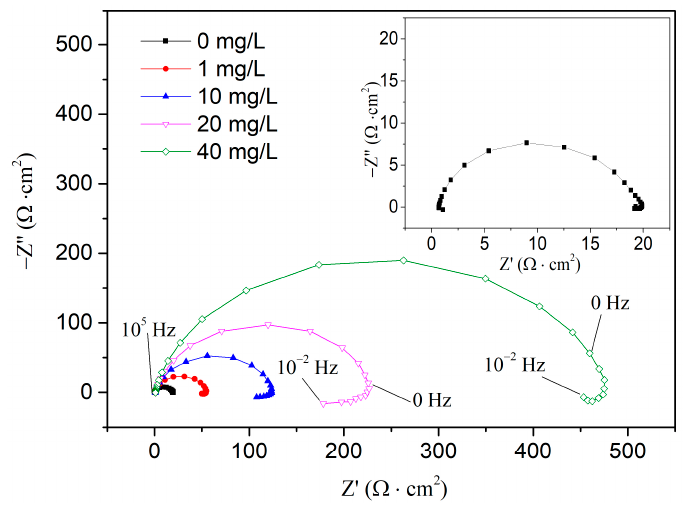
Figure 2. Nyquist plots of the carbon steel electrode immersed in 1 M HCl solutions with different contents of TSCA at 298 K.